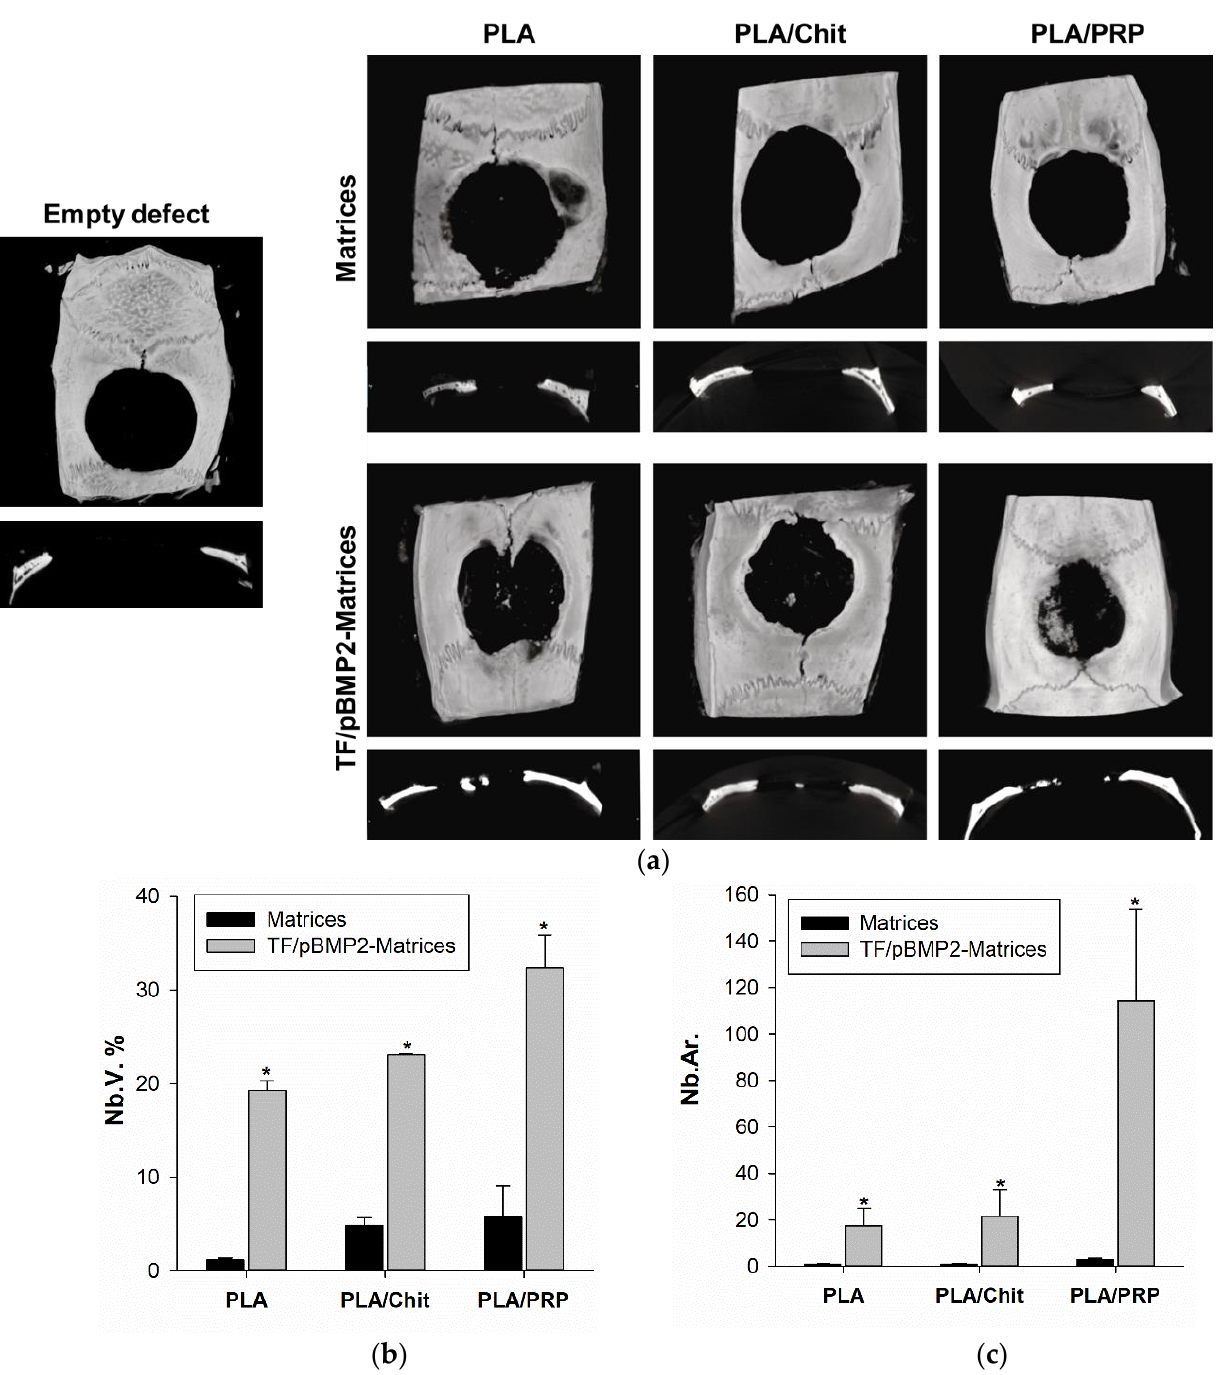
Figure 8. Critical-size bone defect regeneration in rats: ( a ) micro-CT data of critical-size calvarial defect; ( b ) the volume of newly formed bone (Nb.V.) measured using micro-CT; and ( с ) the area of newly formed bone (Nb.Ar.) inside the defect measured using histomorphometrical analysis. * p < 0.05 (relative to nonactivated matrices).